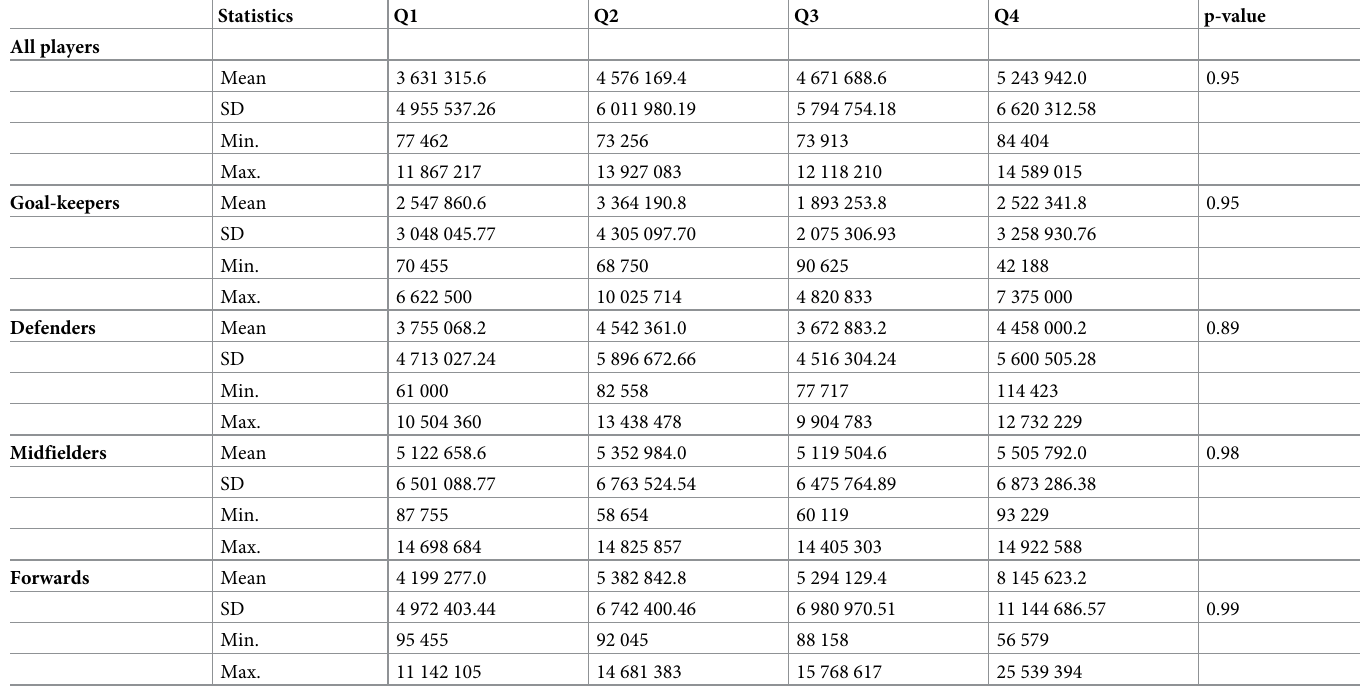
Table 5. Differences between market value across Q1-4—Kruskal-Wallis